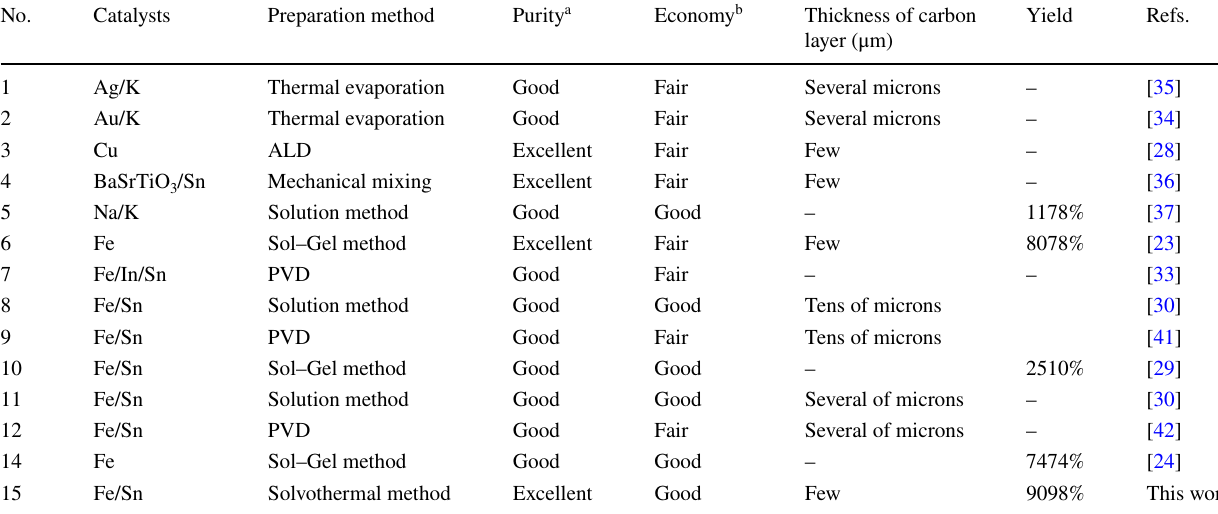
Table 1 Comparison of various catalysts assisted growth of CNCs reported in the literature